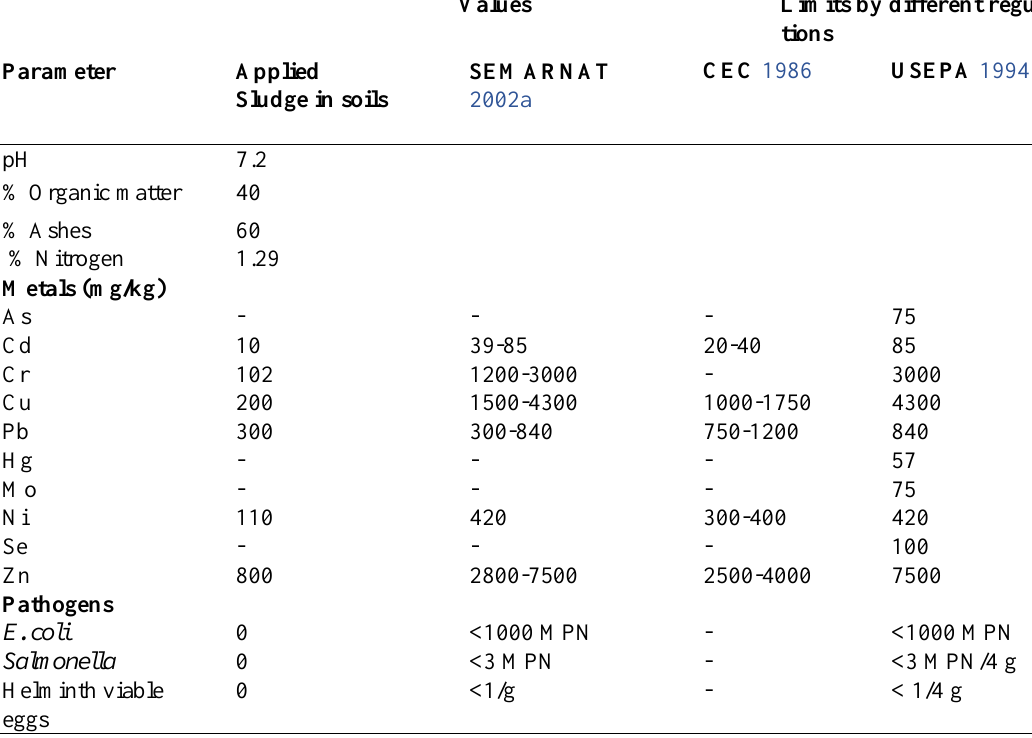
Table 1 Properties of sewage sludge applied in agricultural soils and reference values